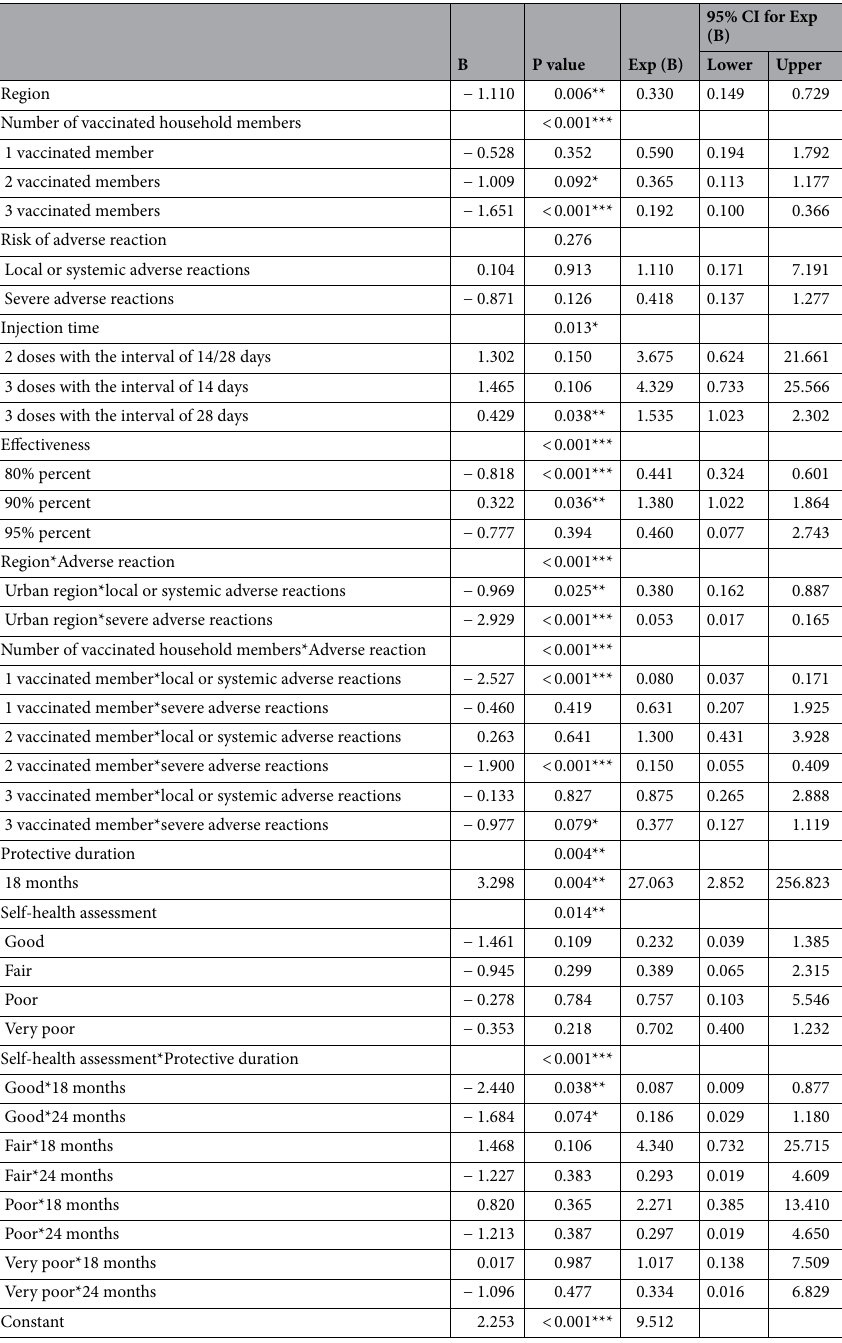
Table 3. Regression results of DCE. *p < 0.1. **p < 0.05. ***p <